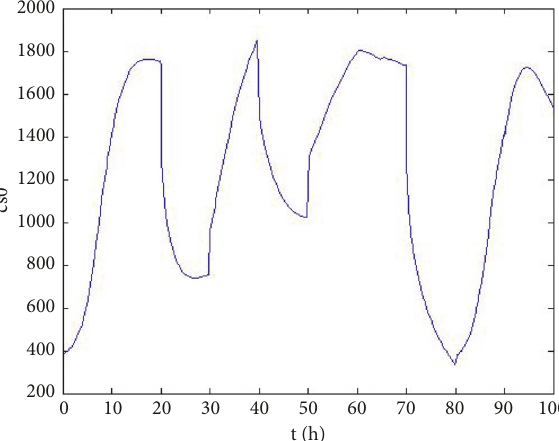
Figure 3: The second feedback control coefficient.